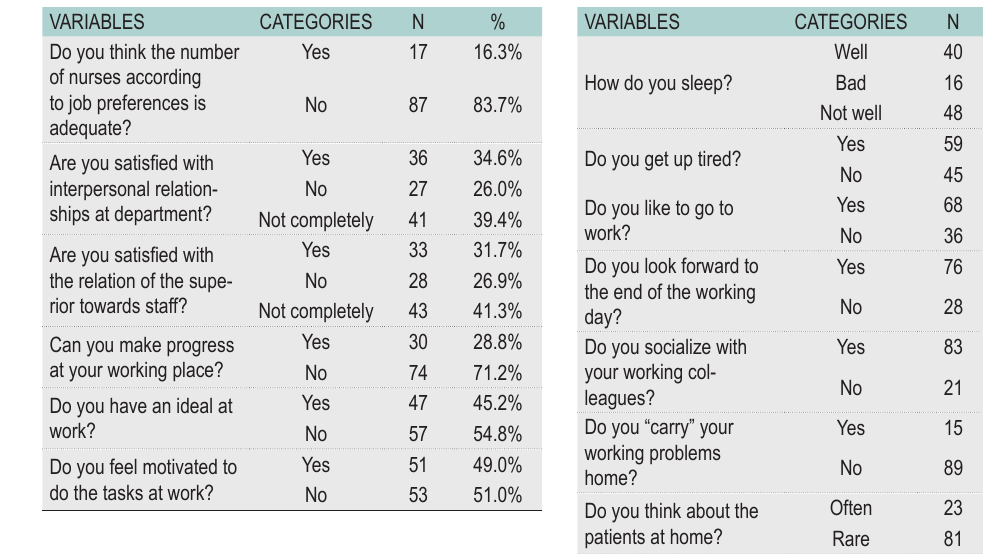
TABLE 1. Questions about the attitude of nurses TABLE 2. Questions about the burnout